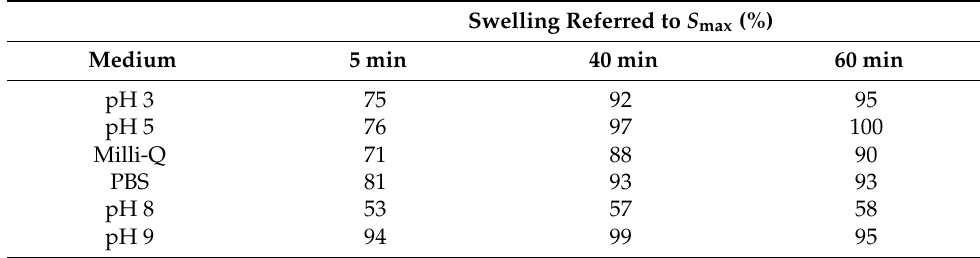
Table 1. Maximum swelling ( S max ) as a function of